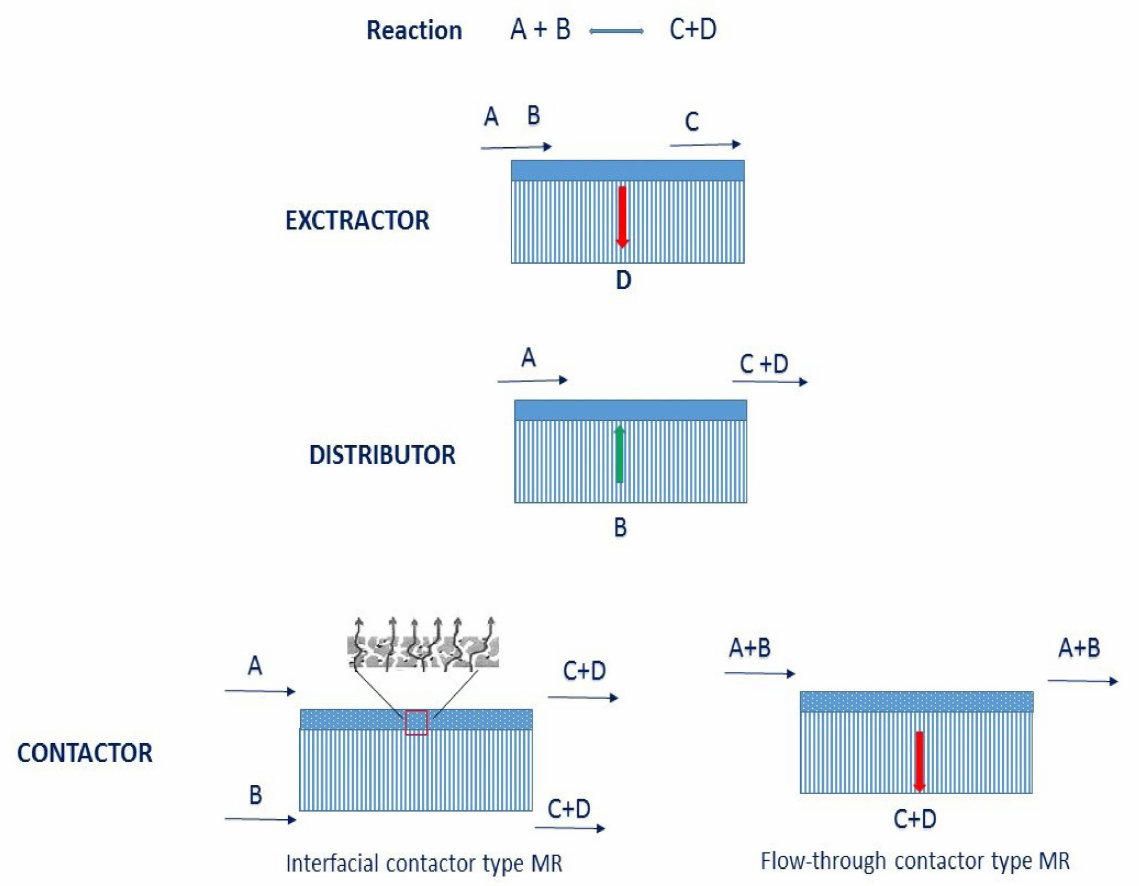
Figure 3. Membrane role in a membrane